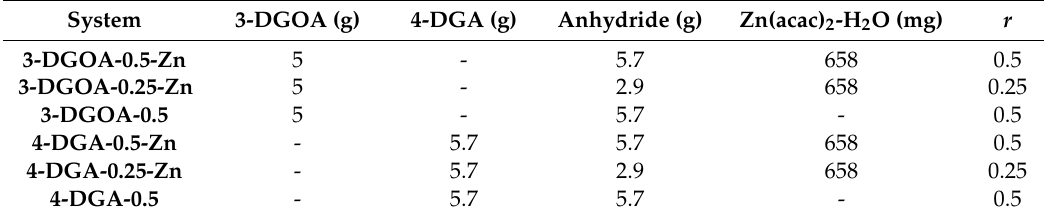
Table 1. Composition of the investigated resin formulations. r denotes the stoichiometric ratio, which was defined as r = anhydride equiv/epoxy equiv.